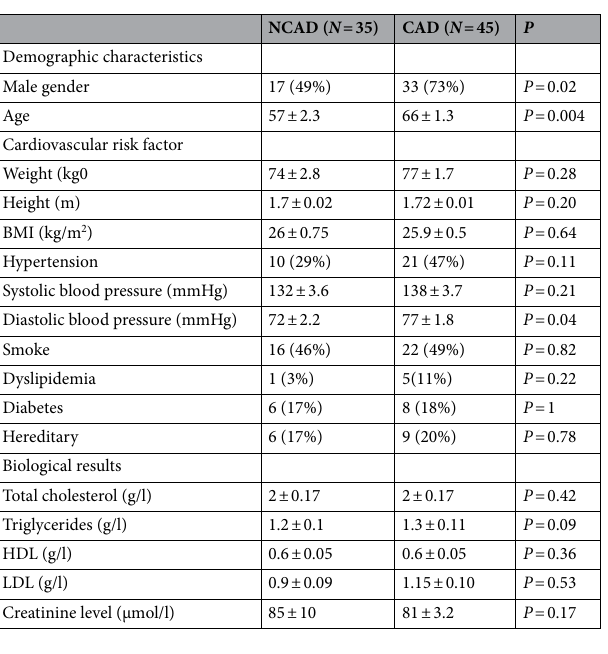
Table 1. Clinical characteristics of patients with and without coronary artery disease. NCAD: No Coronary Artery Disease. CAD: Coronary Artery Disease.